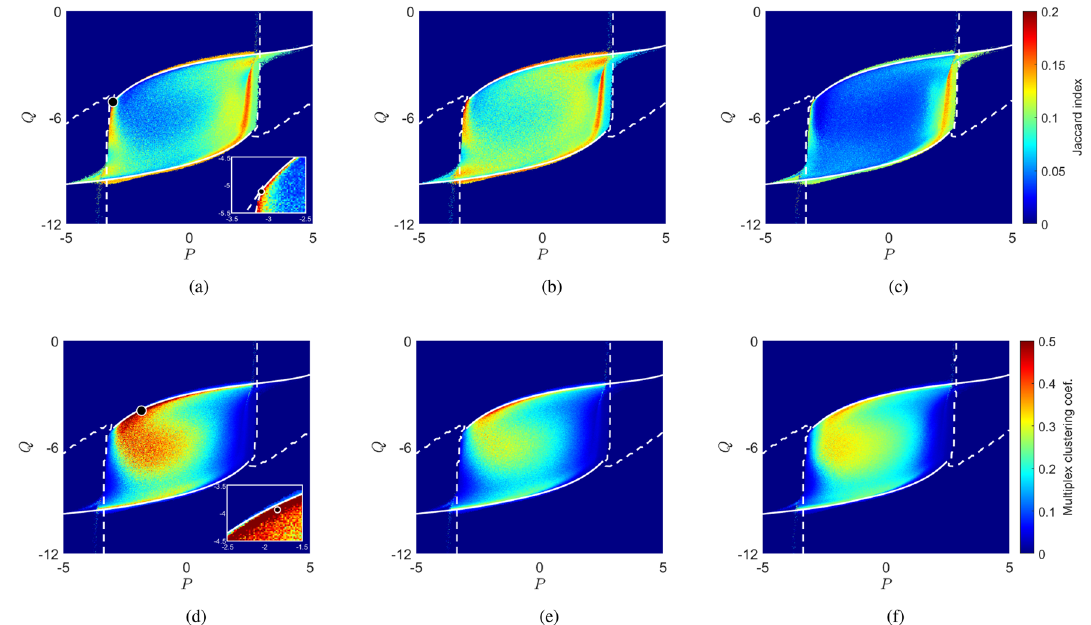
Figure 3. Comparison of the Jaccard index (top row) and structure-function clustering (bottom row) as a function of the basal input parameters ( P , Q ) for the three different cortical representations considered in our investigations: ( a , d ) weighted network; ( b , e ) weighted topological network; and ( c , f ) binary network. Bifurcation sets for each network, obtained as described in “Large-scale neural dynamics” section are superimposed in white; the dashed curve denotes the saddle-node bifurcation set and the solid curve the Hopf bifurcation. Specific parameter choices ( P , Q ) = ( − 3.1, − 5.12 ) and ( − 1.83, − 3.94 ) explored in further detail in Figs. 4, 5 are highlighted by the markers in panels ( a ) and ( d ). Insets show their positions relative to the boundaries of the region of interest and regions of high and low structure-function similarity and